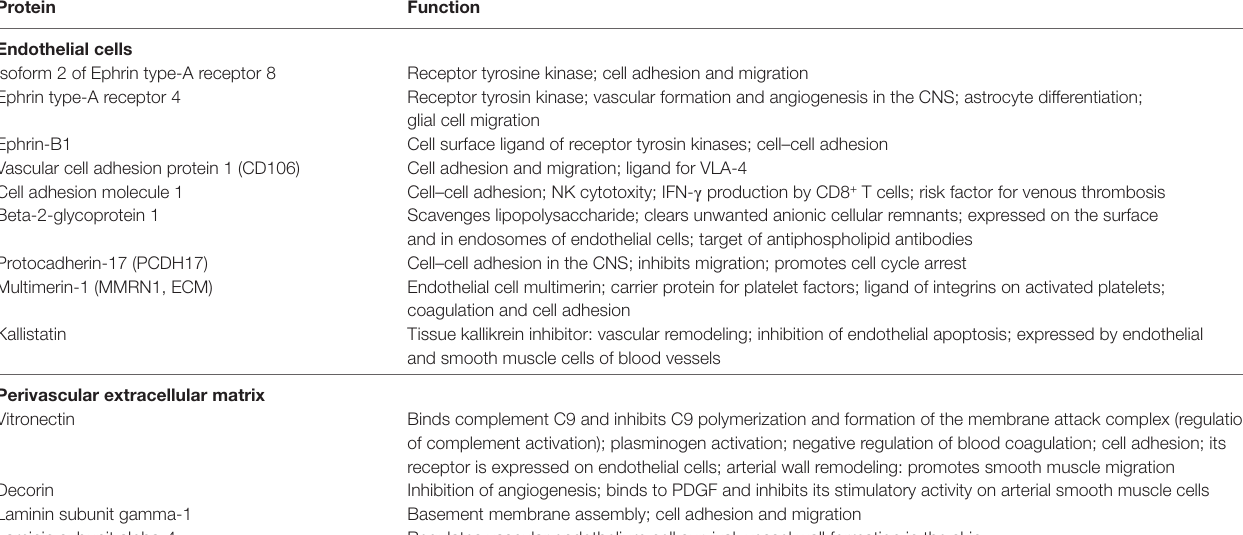
TaBle 2 | Upregulated proteins in the cerebrospinal fluid of patients with chronic lymphocytic inflammation with pontine perivascular enhancement responsive to steroids compared to patients with Alzheimer’s disease. Protein